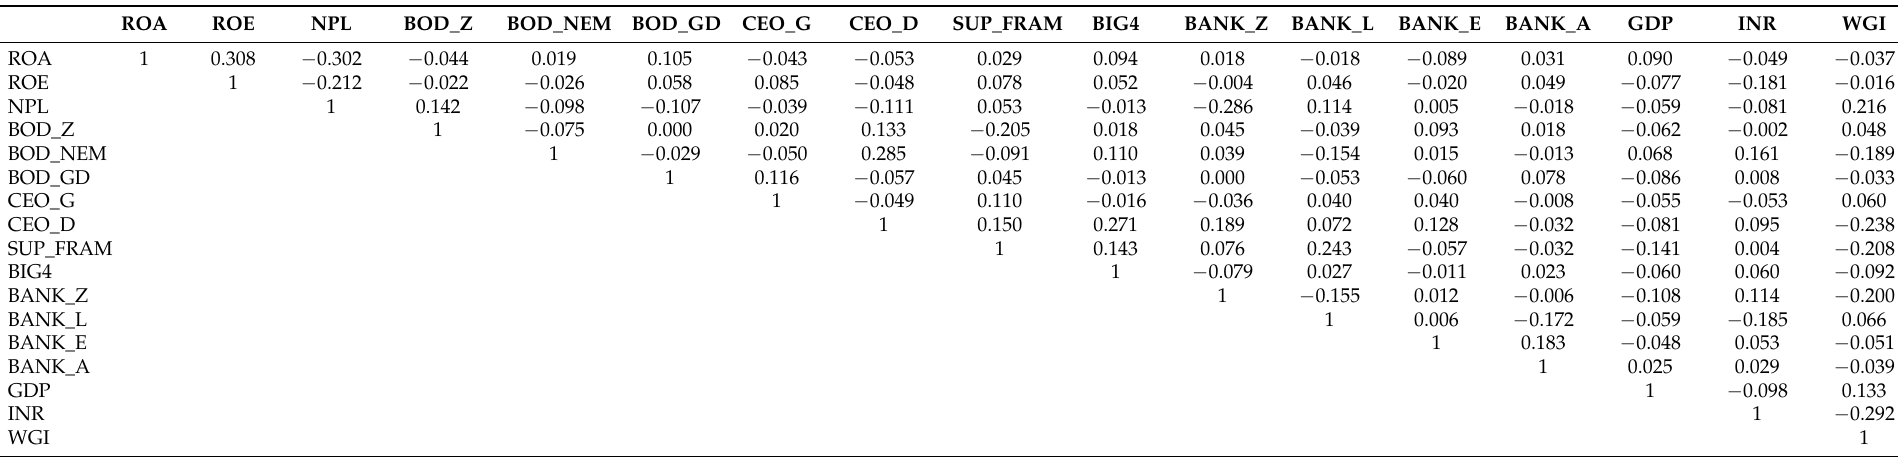
Table A1. Correlation matrix—Conventional banks.